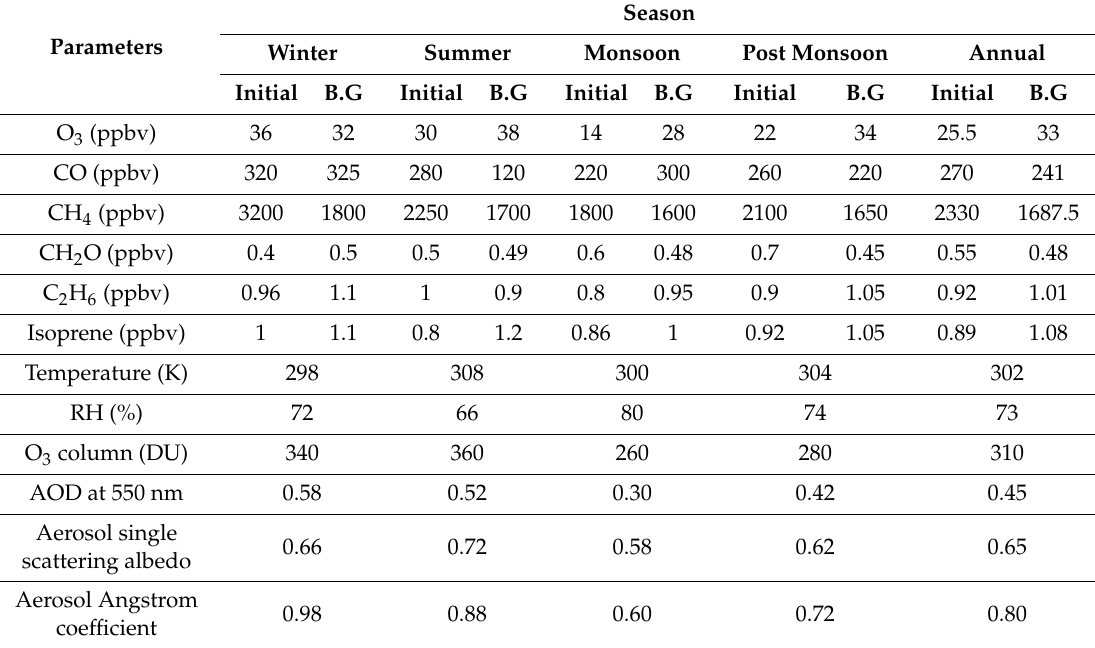
Table 5. Initial and background (BG) values of trace gases and environmental parameters set for model simulation for di ff erent